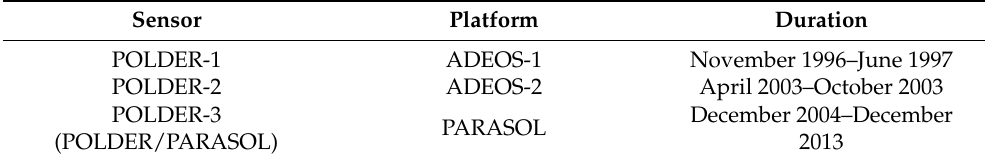
Table 1. History of POLDER development.